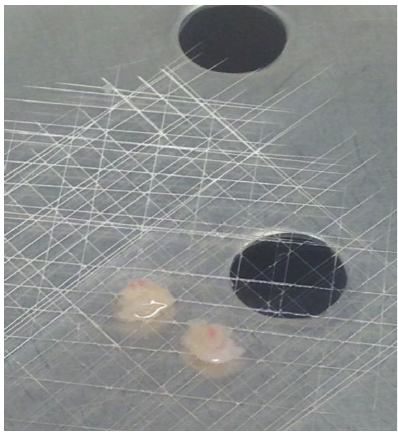
Figure 2: Biopsy sample of small round cell osteosarcoma. Biopsy sample of small round cell osteosarcoma by surgical resection of two small parts of the tumor.